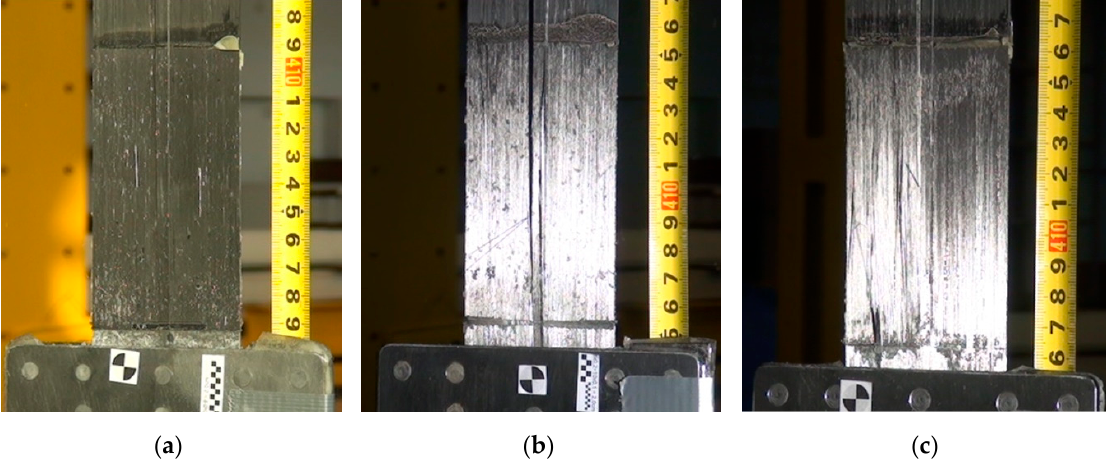
Figure 17. Failure mode of the subsequent specimens in the S3N series: ( a ) P1/S3N, ( b ) P2/S3N, ( c ) P3/S3N.